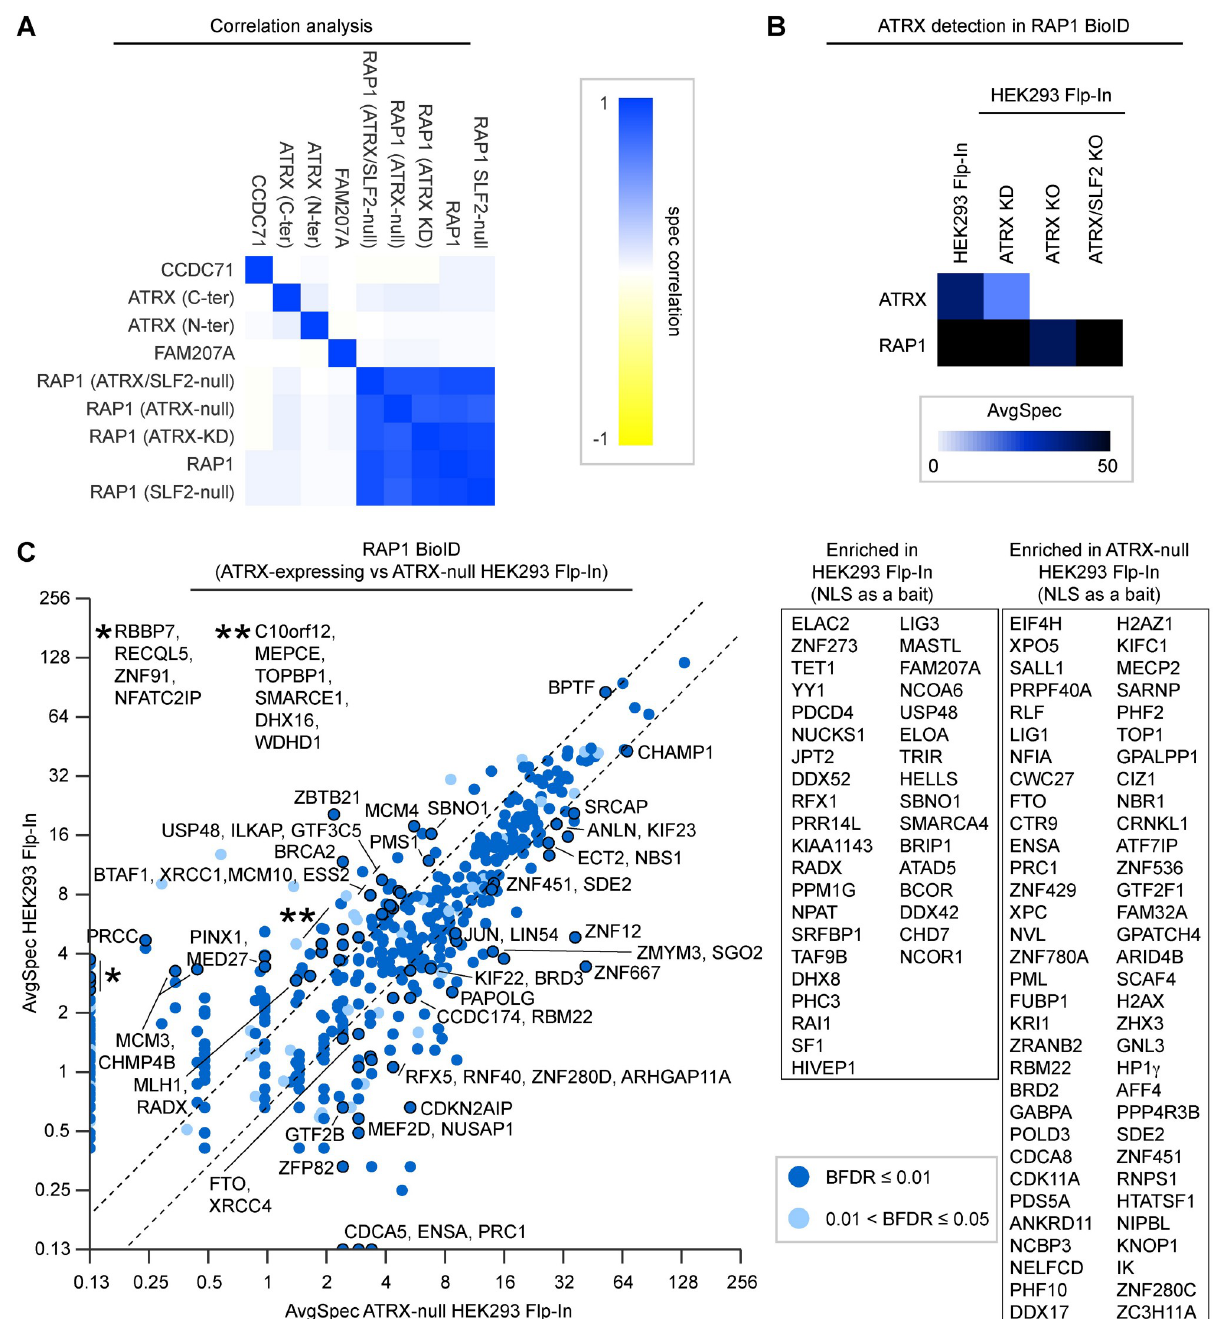
Fig 5. Loss of ATRX changes the enrichment of a subset of proteins at telomeres. A: Correlation between BioID bait proteins. RAP1 BioID experiments strongly correlated with one another independently of ATRX expression. B: Relative ATRX detection by RAP1 BioID in ATRX-expressing and isogenic cells where ATRX expression was knocked-down (KD) using shRNA or knocked-out (KO) using CRISPR-Cas9. C: Fold change of prey proteins identified by RAP1 BioID (BFDR � 5%, SAINT [103]) in ATRX-expressing vs. ATRX-null HEK293 Flp-In cells. Labeled proteins had � 2.5 average spectra and � 1.5-fold change between conditions. Proteins labeled in the scatter plot remained significant when NLS-BirA � was used as a control. Inset box represents additional proteins identified with NLS-BirA � as a bait (less stringent).